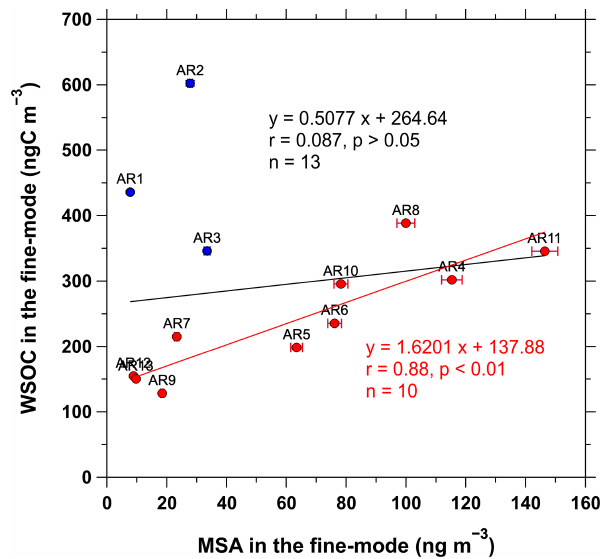
Figure 5. Relationship between WSOC (ngCm − 3 ) and MSA (ngm − 3 ) in the fine-mode aerosols ( D< 2 . 5µm) collected during the cruise. The solid blue and red circles indicate the samples col- lected from the coastal and sea-ice-covered areas, respectively. The black and red lines indicate the correlations between WSOC and MSA for the all samples collected during the cruise and for the aerosol samples collected in the sea-ice-covered areas of the west- ern Arctic Ocean,